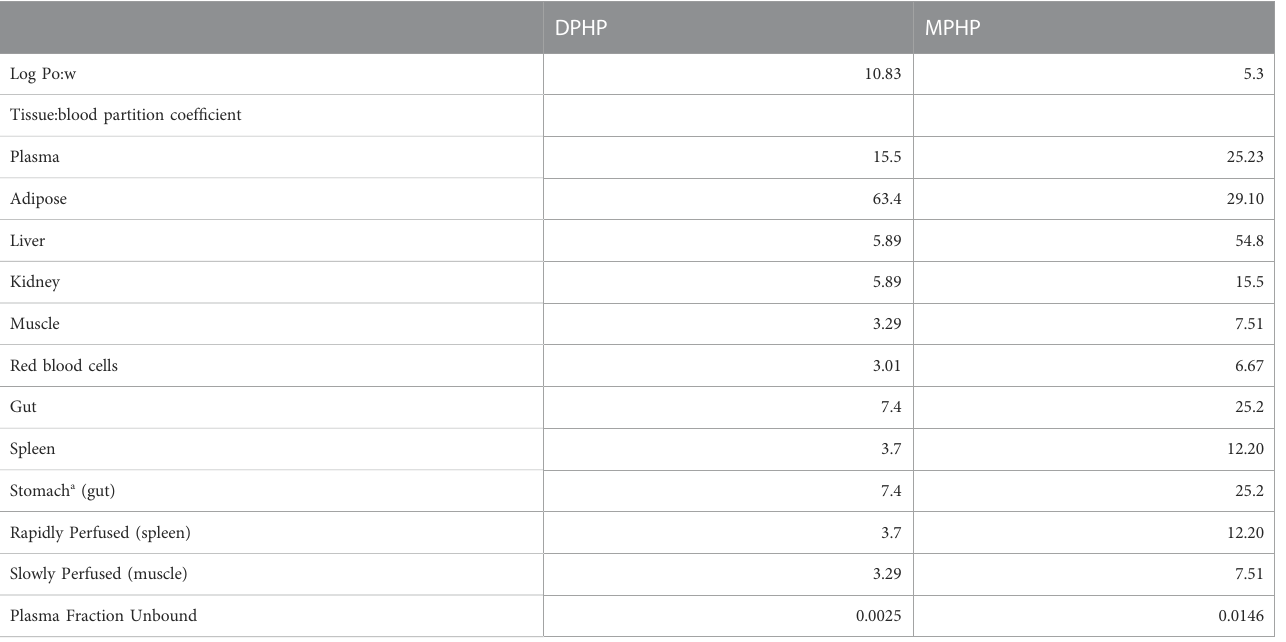
TABLE 1 Tissue:blood partition coef fi cients and plasma fraction unbound predicted using Log P ow